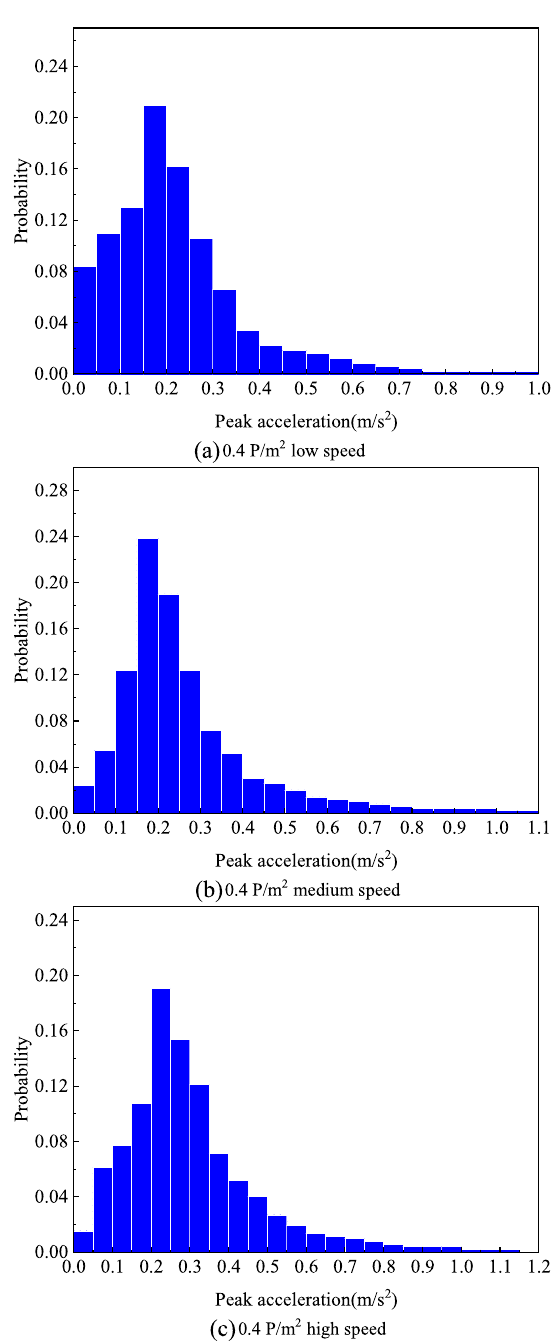
Fig. 9 Probability distribution of peak acceleration when the crowd density is 0.4 P/m